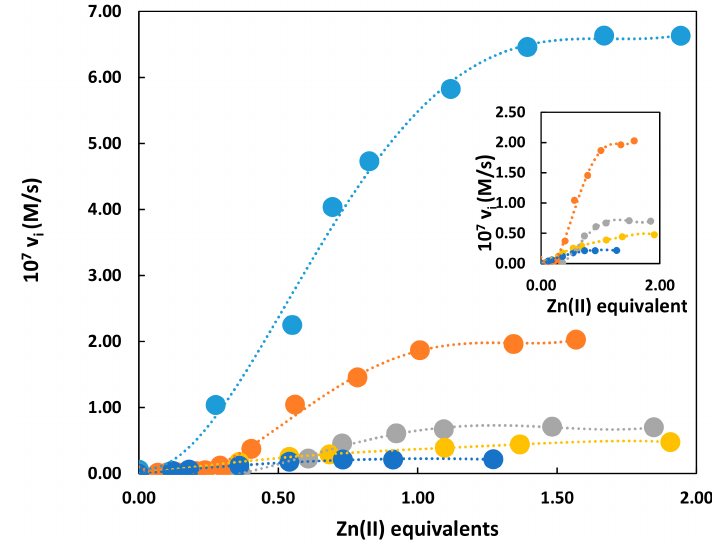
Figure 2. Titration kinetics obtained by adding Zn(NO 3 ) 2 to the solutions of the di ff erent gold nanoparticles (AuNPs). Conditions: pH = 7.5, 25 ◦ C, [HPNP] = 1.0 × 10 − 5 M. Symbols code: AuNP1: Light blue; AuNP2: Orange; AuNP3: Gray; AuNP4: Yellow; AuNP5: Dark blue. Inset: Blown-up plot without the AuNP1